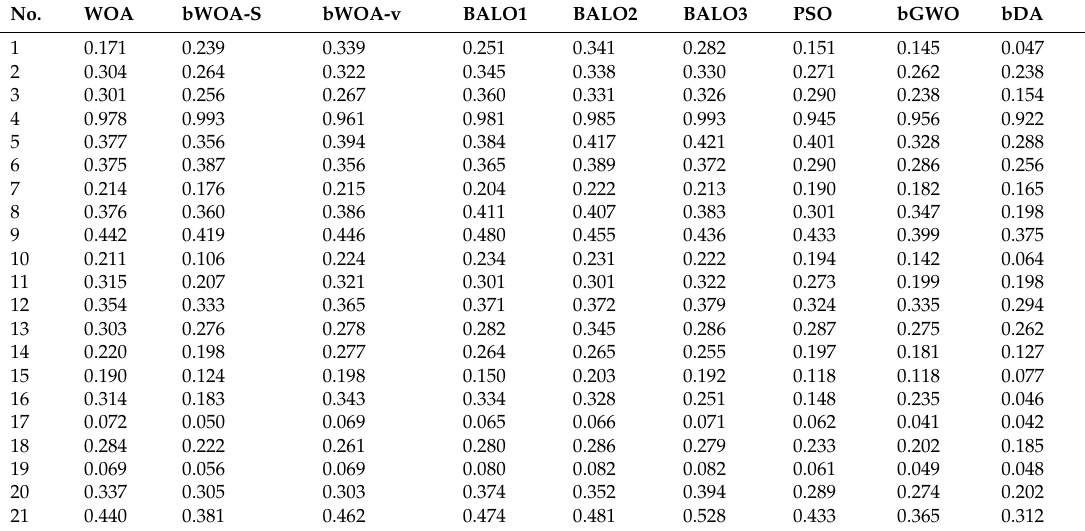
Table 13. Worst fitness function on the different datasets averaged for the compared algorithms over the three initialization